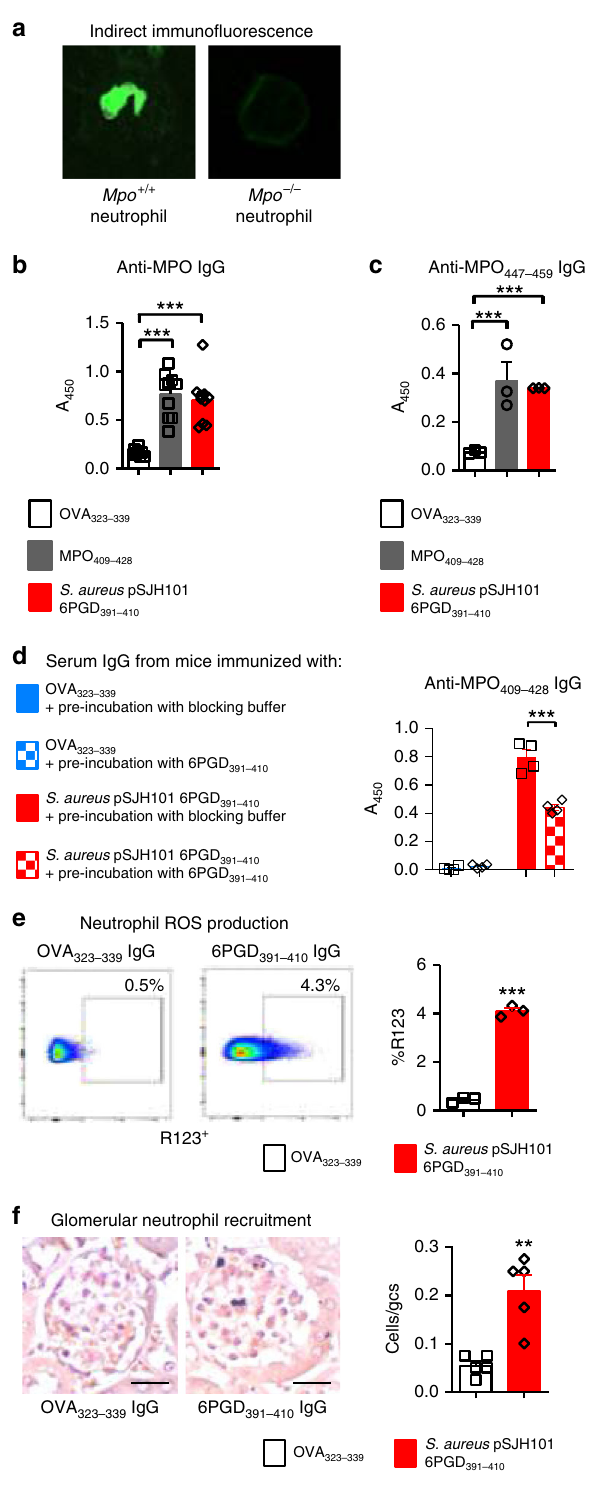
Fig. 3 MPO-ANCA production in S. aureus pSJH101 6PGD 391 – 410 immunized mice. a Serum IgG from S. aureus pSJH101-derived 6PGD 391 – 410 immunized C57BL/6 mice (pooled, n = 8) binds to neutrophils from C57BL/6 mice, but not those from Mpo − / − mice in a perinuclear (pANCA) fashion. b Anti- MPO ELISA on sera from mice immunized with OVA 323 – 339 ( n = 8), MPO 409 – 428 ( n = 10), or pSJH101 6PGD 391 – 410 ( n = 10,